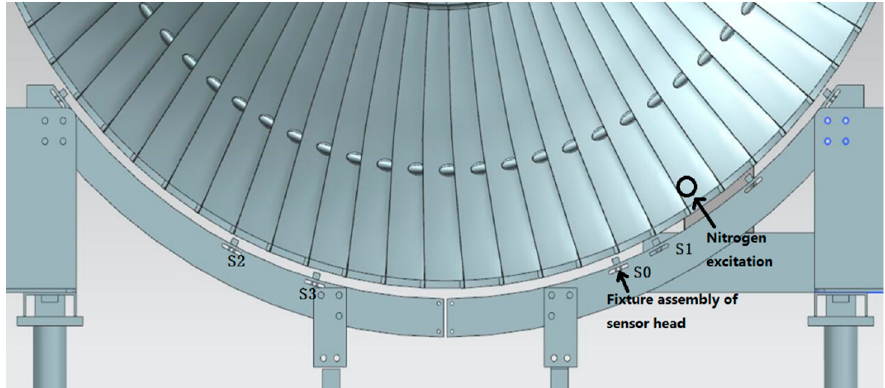
Figure 6. Locations of sensors, nitrogen excitation, and strain gauges.